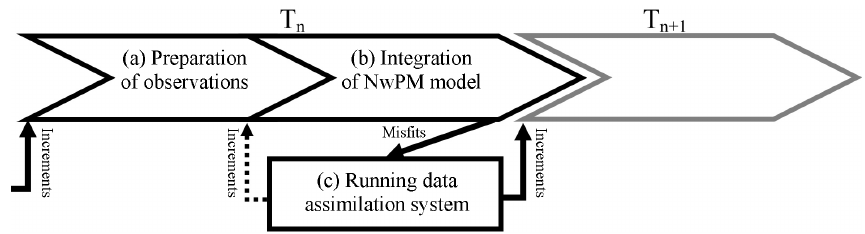
Figure 2. Flow chart of the system: T n represents the system running date and T n + 1 represents the next system running date.